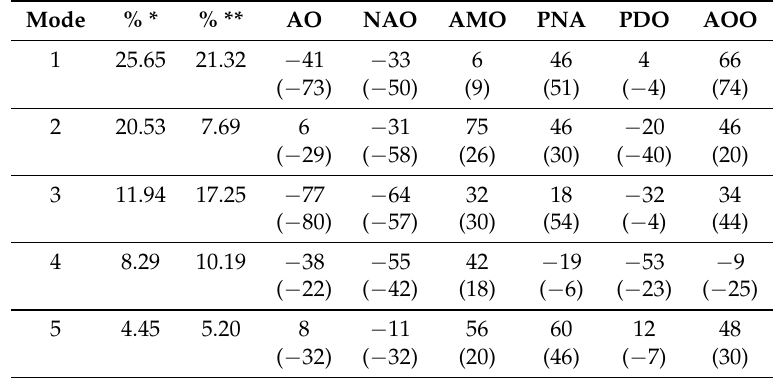
Table 1. Correlation (%) of the principal components of the surface wind EOF decomposition with the well-known circulation indexes: AO, NAO, AMO, AOO, PNA, PDO, taken from the site https: //www.whoi.edu/page.do?pid=66578 (*—a fraction of the wind field variability explained by this mode, **—a fraction of the seasonal variability of the mode in its total variability). Mode % * % ** AO NAO AMO PNA